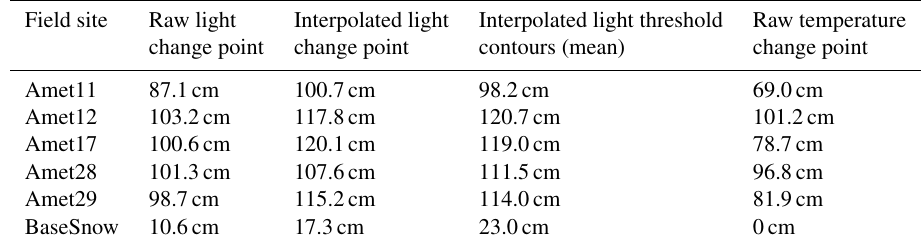
Figure 9. Snow depth over winter 2018–2019 derived from change-point analysis applied to standard deviations of daily temperature for each SCLT measurement site including (a) Amet11, (b) Amet12, (c) Amet17, (d) Amet28, (e) Amet29 and (f) BaseSnow. Top logger positions for SCLT sites ranged from 120cm (Amet11 and BaseSnow) to 160cm (Amet12, Amet17, Amet28, Amet29) and cannot detect snow depths above this height. Table 3. Mean January snow depth for all six stations using all methods.